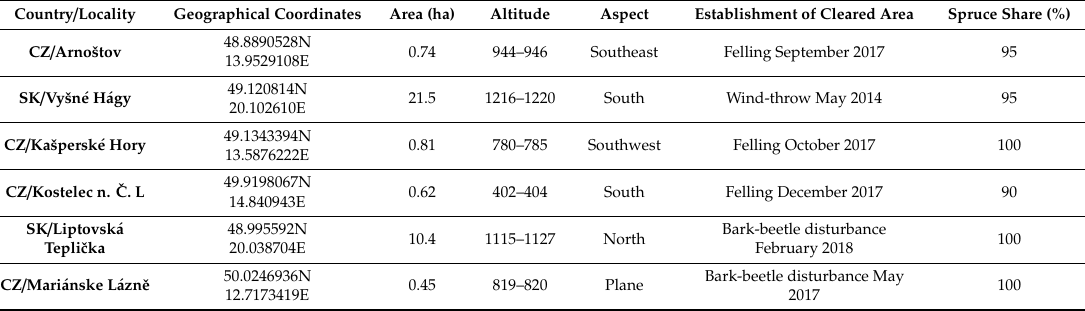
Figure 1. The six localities in the Czech Republic and Slovakia used in the current study. Table 1. Description of study localities .